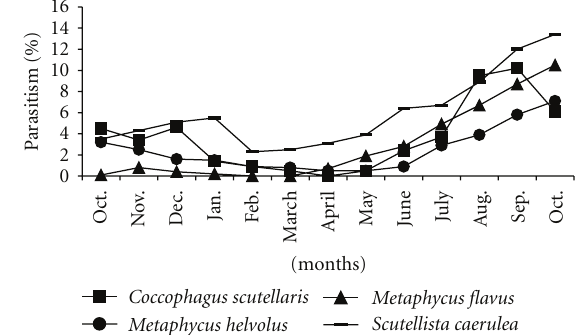
Figure 11: Percent parasitism of Coccophagus scutellaris and other associated parasitoids of Saissetia co ff eae on olive in Marsa Matruh governorate after releasing during 2009-2010.